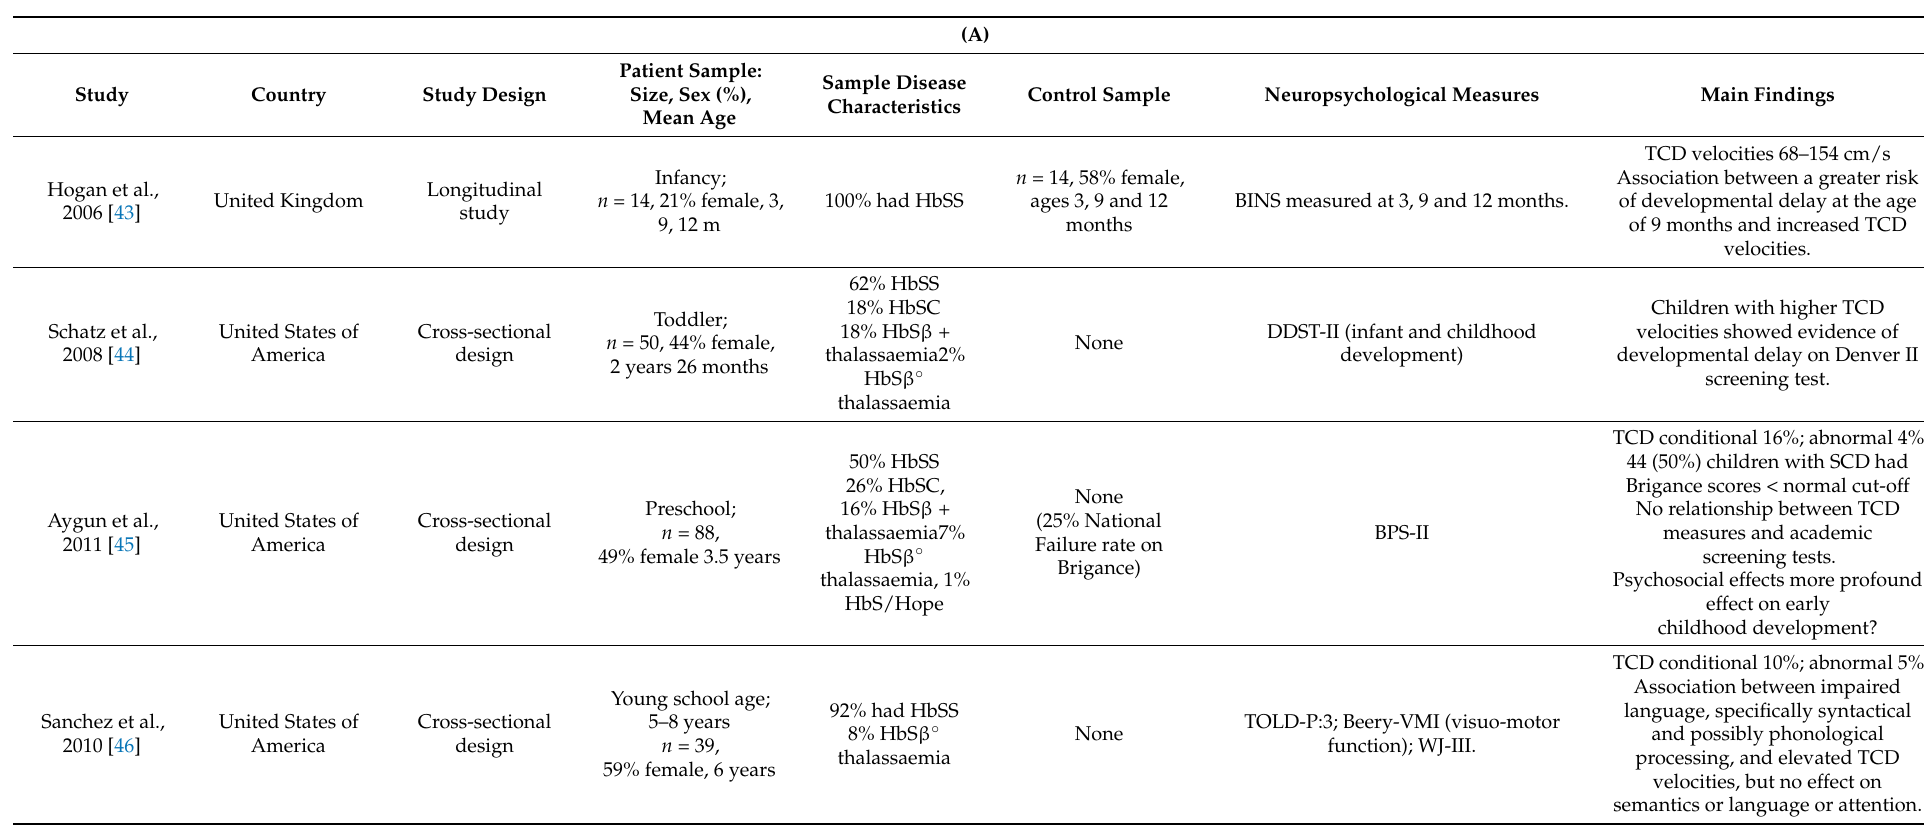
Table 3. (A). Characteristics of transcranial Doppler (TCD) articles included in the systematic review. (B). Characteristics of SCI on Structural MRI articles included in the systematic review. (C). Characteristics of volume on structural MRI articles included in the systematic review. (D). Characteristics of diffusion tensor imaging articles included in the systematic review. (E). Characteristics of functional MRI articles included in the systematic